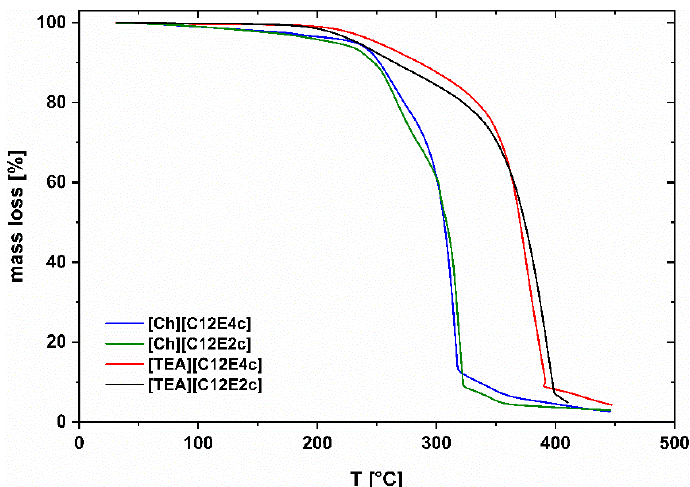
Figure 4. Temperature-dependent mass loss curves. Comparison of different counterions and degree of ethoxylation, adapted from Reference [15].